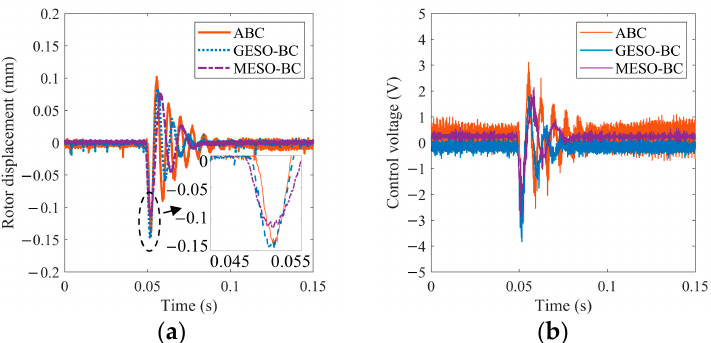
Figure 12. Response waveforms under 3 N pulse disturbance experiments: ( a ) Rotor displacement; ( b ) control voltage. ( b ) control voltage.